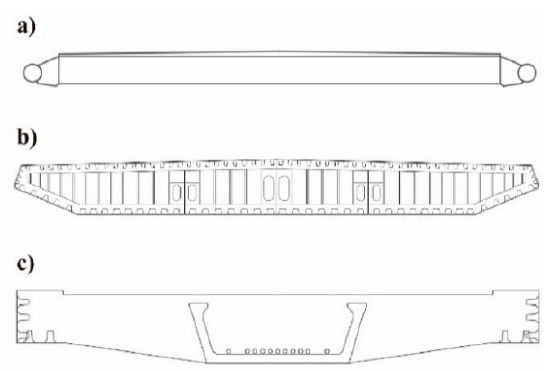
Figure 35. Transversal arch cross-sections (not at the same scale)—( a ) Hulme Arch Bridge and ( b ) Yueniang Arch Bridge. ( c ) AP-36 Bridge.